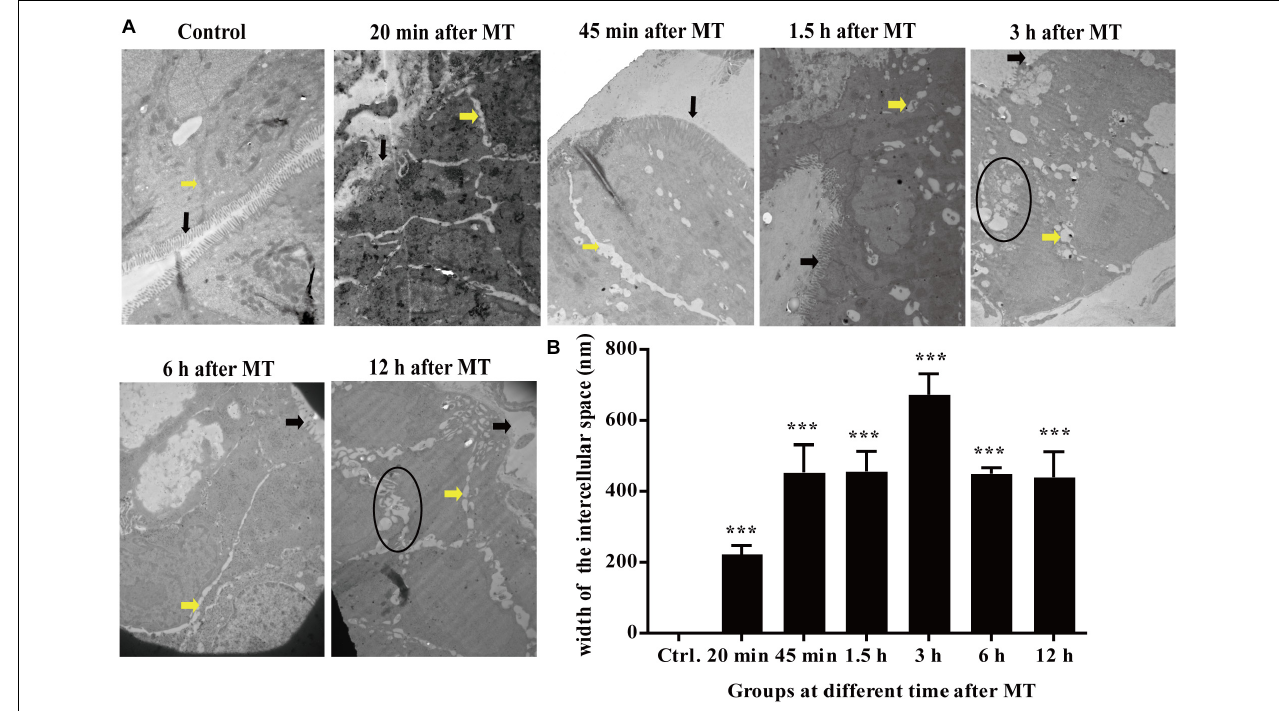
FIGURE 5 | Changes in the microvilli and the cell junctions of cecal mucosa in the SD rats at different time points after MT (12,000 × ). (A) The black arrow in the figure was referred to the location of the microvilli. The yellow arrow was referred to the location of the cell junction. The areas in the black circle showed obvious vacuolated changes are found at 3 and 12 h. (B) Mean ( ± SEM) width of cell connections at different time points (*** P < 0.001 vs. the control).